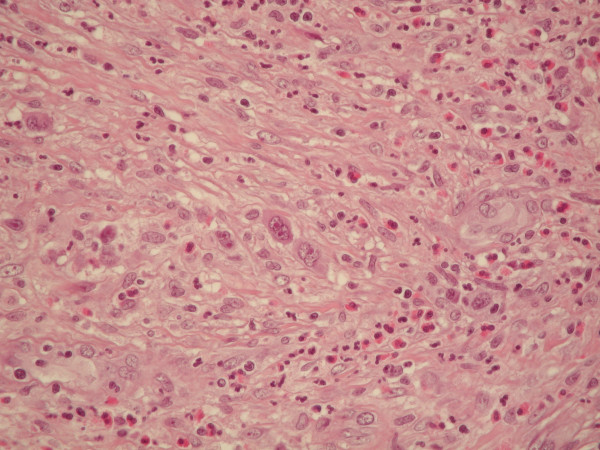
H&E stained sections of lymph node (fig.1) and skin (fig.2) excision in which the diagnostic Reed-Sternberg cell support the diagnosis of Hodgkin disease.